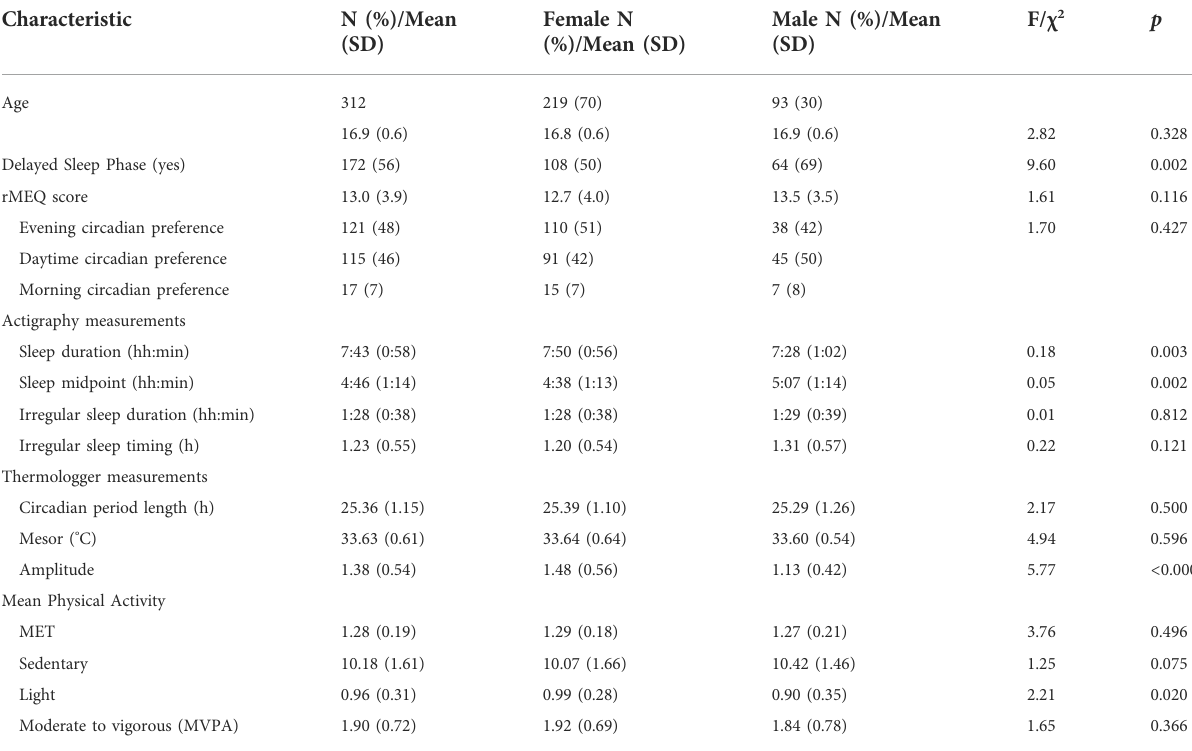
TABLE 1 Descriptive characteristics of the